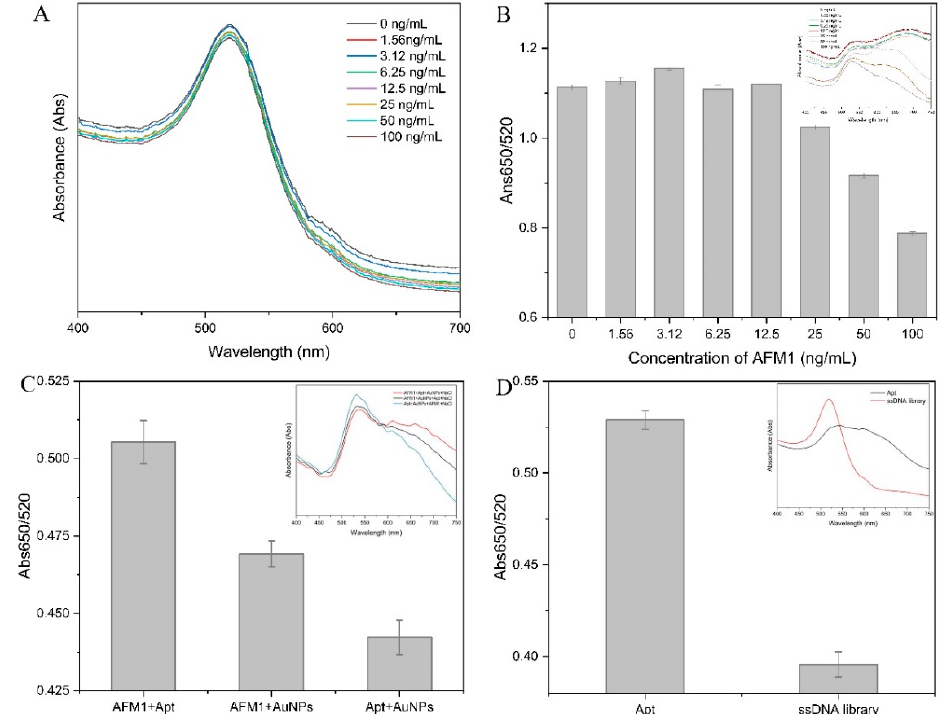
Figure 4. UV-vis spectra of AuNPs in the absence ( A ) and presence ( B ) of NaCl in the presence of different concentrations of AFM1. ( C ) The effect of AFM1, aptamer, and AuNPs reaction sequence. ( D ) Comparison of binding ability of aptamer and ssDNA library.